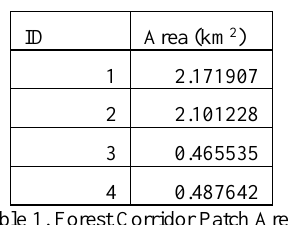
Table 1. Forest Corridor Patch